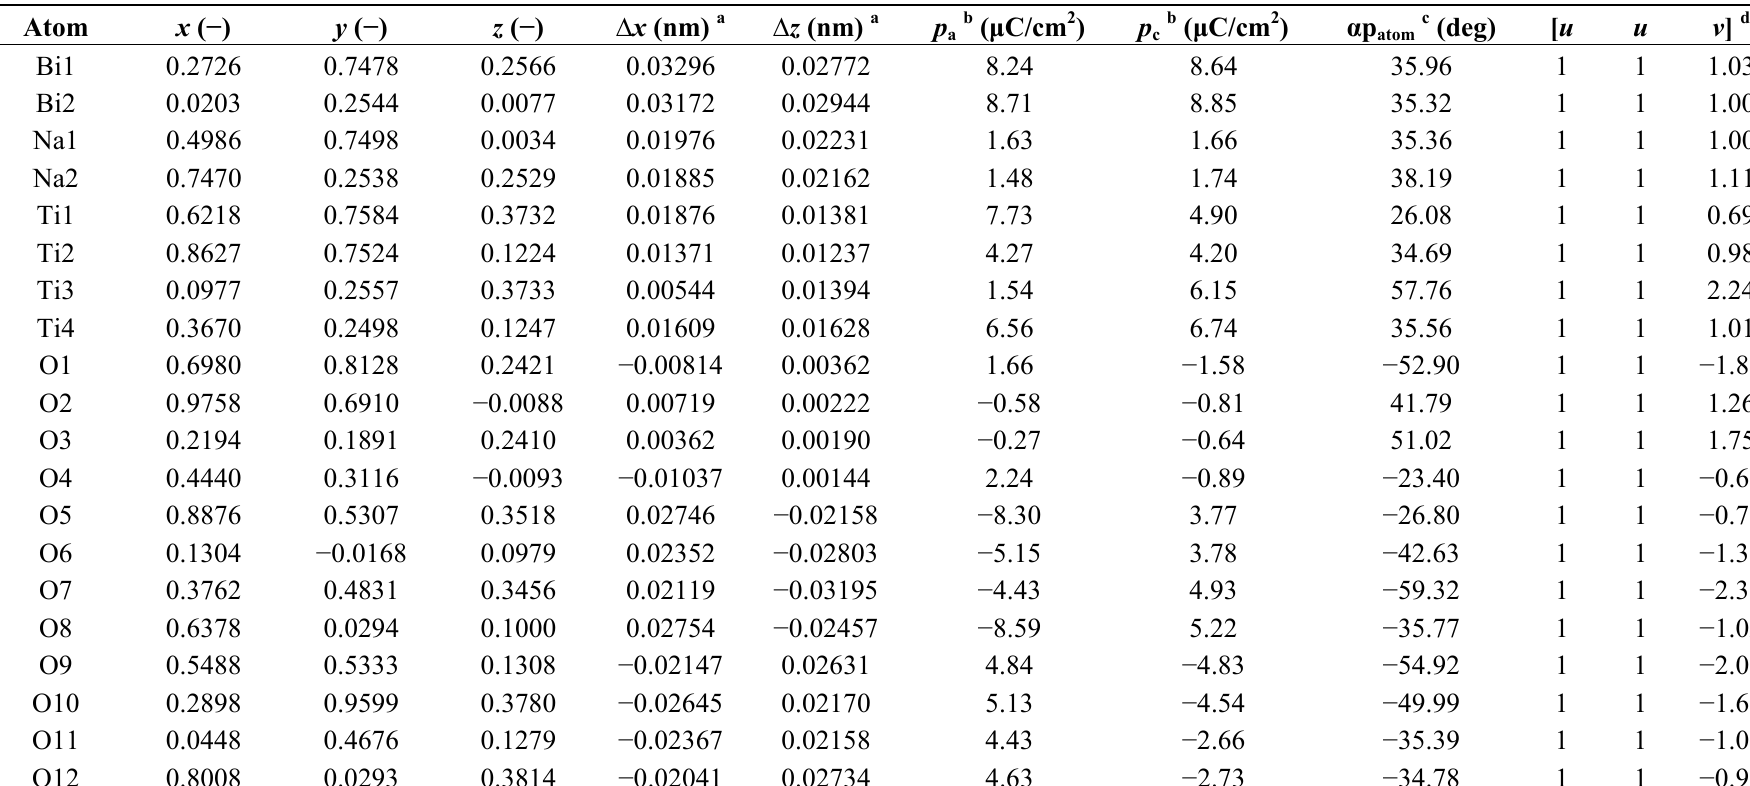
Table 5. Structural parameters obtained by the DFT calculations for BNT ( E were used: a = 0.55124 nm, b = 0.54825 nm, c = 1.65376 nm, α = γ = 90.0000°, and β = 70.0105°. The P of 38.2° is